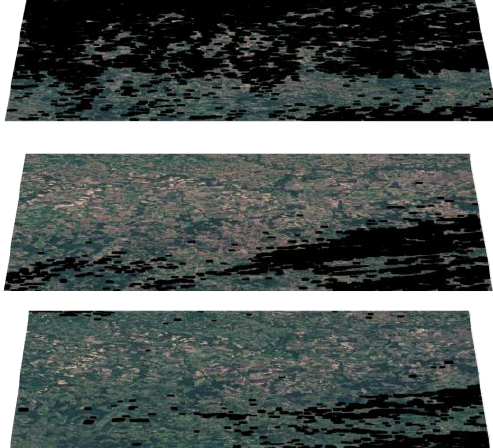
Figure 8: Input imagery stack.